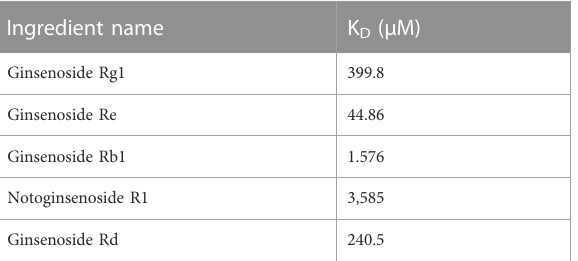
TABLE 3 K D of the fi ve ingredients binding to Ywhaz